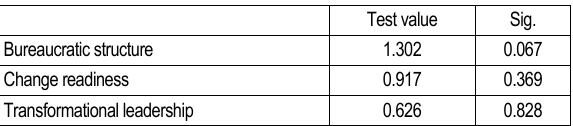
Table 6. Kolmogorov-Smirnov test for variables